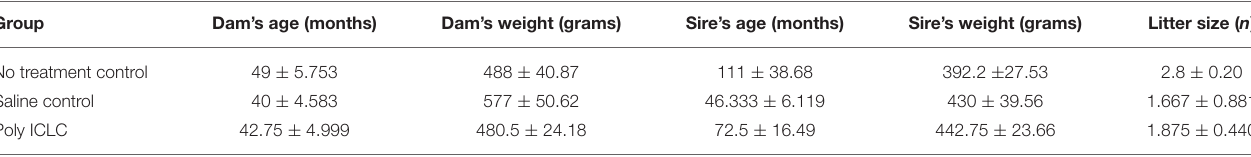
TABLE 2 | Summary of parental characteristics and pregnancy outcomes. Group